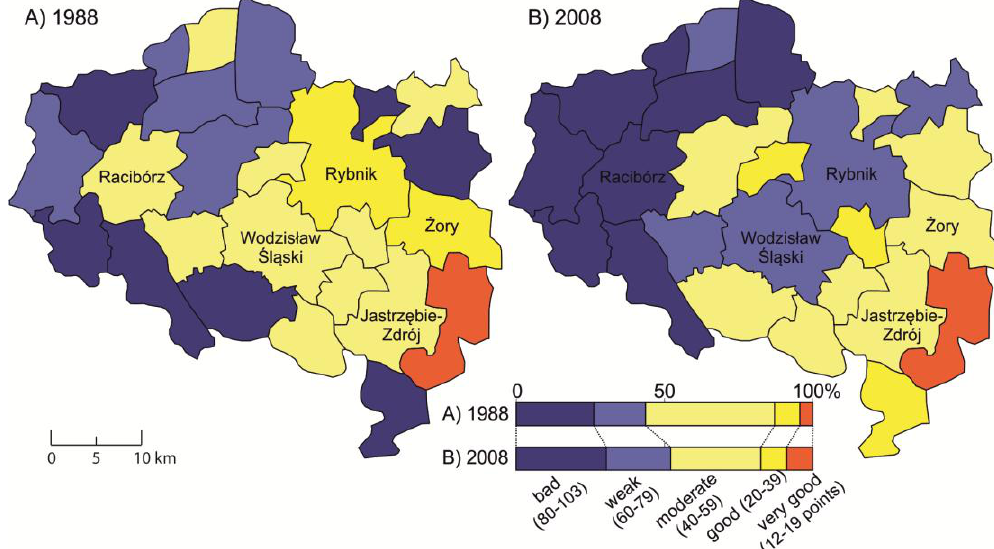
Fig. 2. The demographic situation in the area of Rybnik conurbation in 1988 and 2008, in administration boundaries from 1978* (authors elaboration based on Ludność. Warunki mieszkaniowe. Narodowy Spis Powszechny z dn. 6 XII 1988 r., 1990,